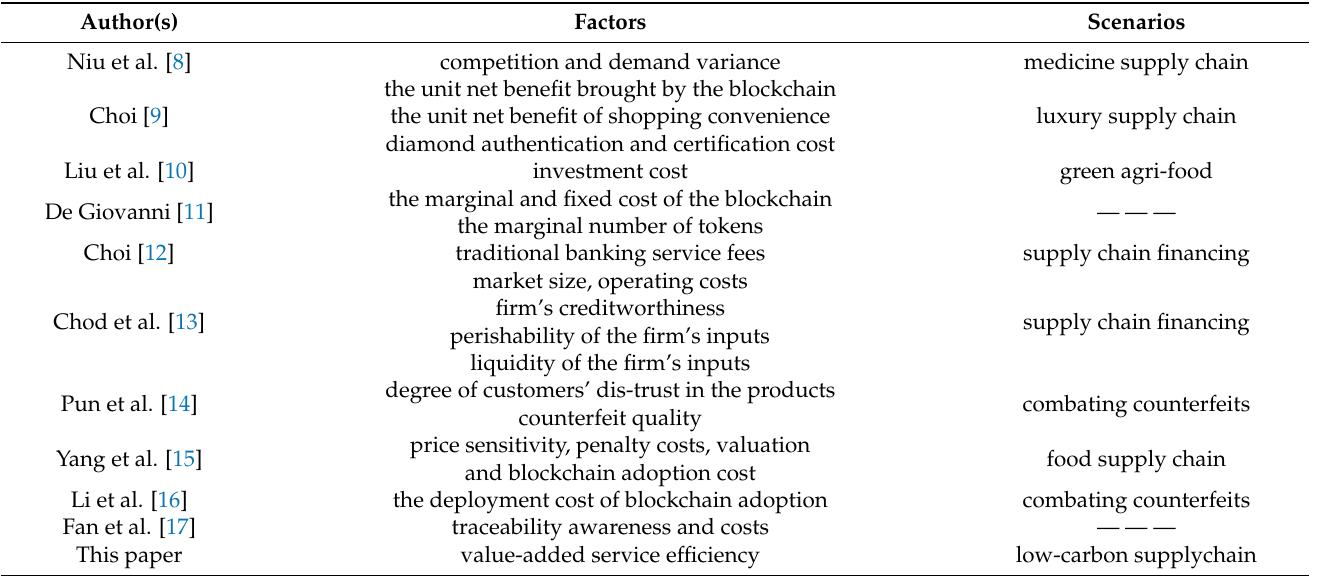
Table 1. Blockchain adoption in the low-carbon supply chain mainly focuses on the concep- tual framework and system design based on the distributed ledger or smart contract [6]. In practice, blockchain technology has also been applied to carbon emissions. For example, the “Tianmu fruit bamboo shoots” from China’s Zhejiang province introduce a digital carbon label, which can trace the carbon footprints of products in the production process. All car- bon data is recorded and stored in the blockchain [7]. Blockchain technology enhances the transparency of carbon emissions and strengthens consumer trust in carbon labels, eliminat- ing “greenwashing” concerns. Furthermore, demand uncertainty also causes considerable challenges to supply chain operations. Suppliers can obtain more accurate demand signals when retailers record their sales in the blockchain [8]. Transparency of demand information benefits the supply chain, which improves operational efficiency. Therefore, it is critical to research the application of blockchain in the low-carbon supply chain. Table 1. The factors affecting blockchain